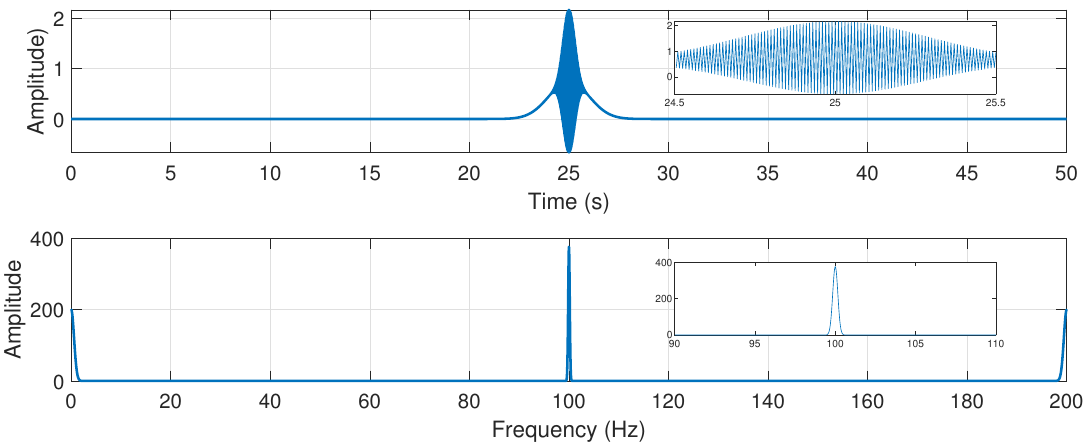
Figure 4. Multi-band window (15) in the time domain (top) and in the frequency domain (bottom). This window contains 2 Gaussian windows, in 2 adjacent frequency bands of 100 Hz, one with α = 1 and the other one with α = 12.6.